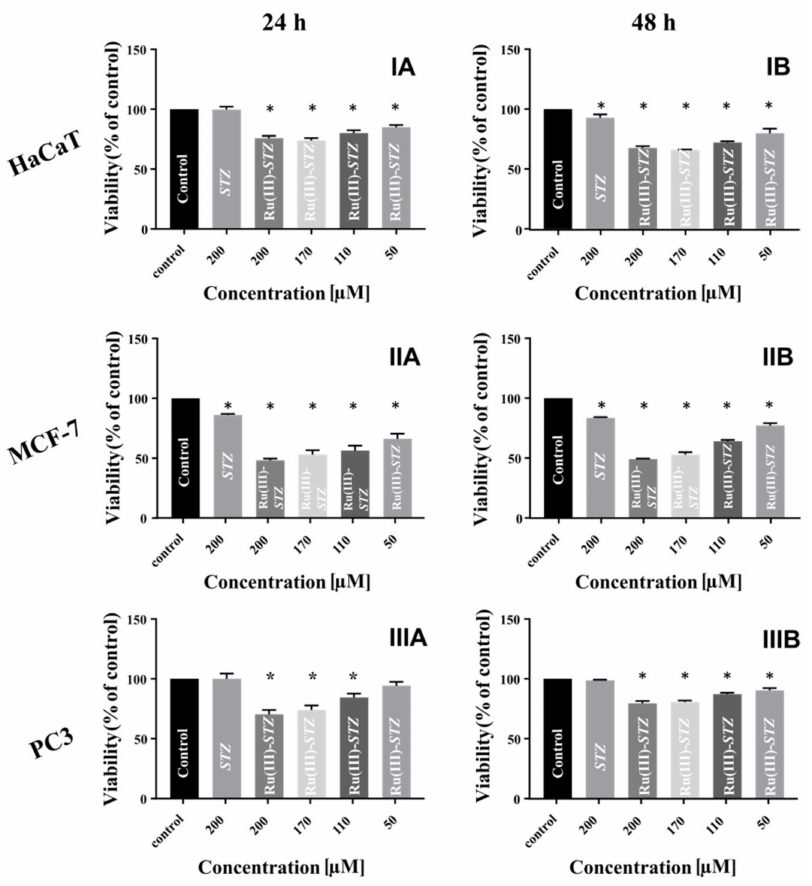
Figure 8. The viability of I. HaCaT, II. MCF-7 and III. PC3 cells after: ( A ) a 24 and ( B ) a 48 h treatment with STZ and Ru(III)-STZ complex in the range of concentration from 0 (control) to 200 µ M. Results are shown as mean ± SD of three independent experiments performed in triplicate. * Statistically significant difference is present between treated cells compared with untreated cells